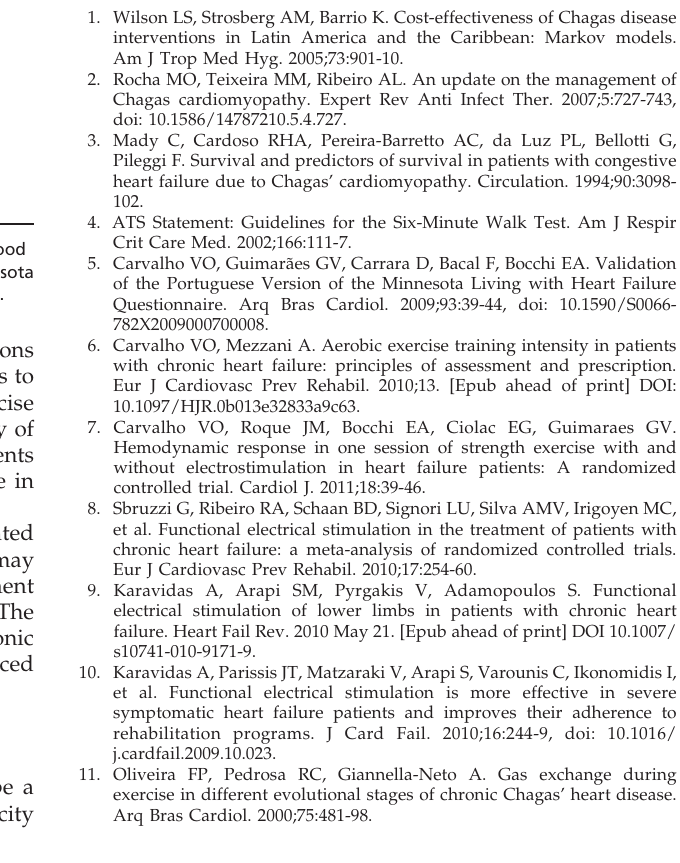
during cardiac rehabilitation in a CHF patient with Table 1 – Patient data before and after NMEE treatment. Chagas disease. Further studies are necessary to better Before After NYHA functional